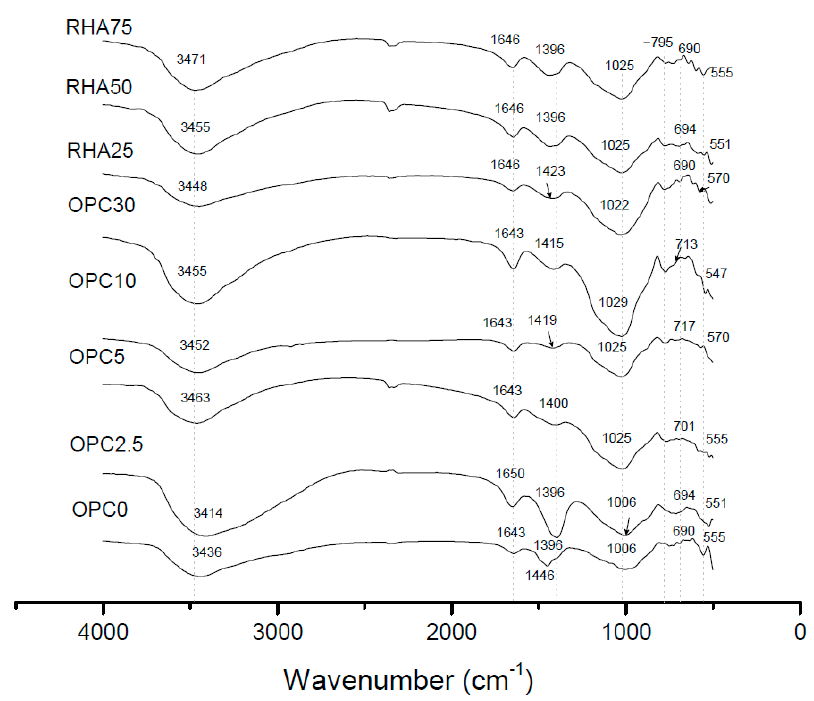
Figure 14. FTIR of the binary and ternary samples at 28 days of age.